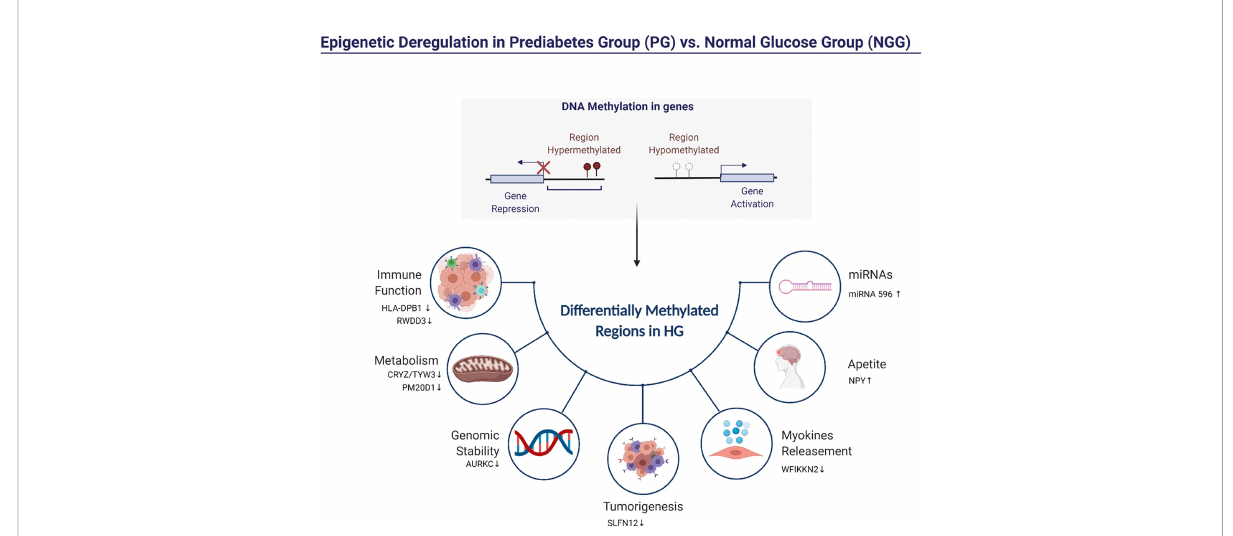
FIGURE 4 Representation of the pathways possibly in fl uenced by differentially methylated regions (DMRs) in PG vs.